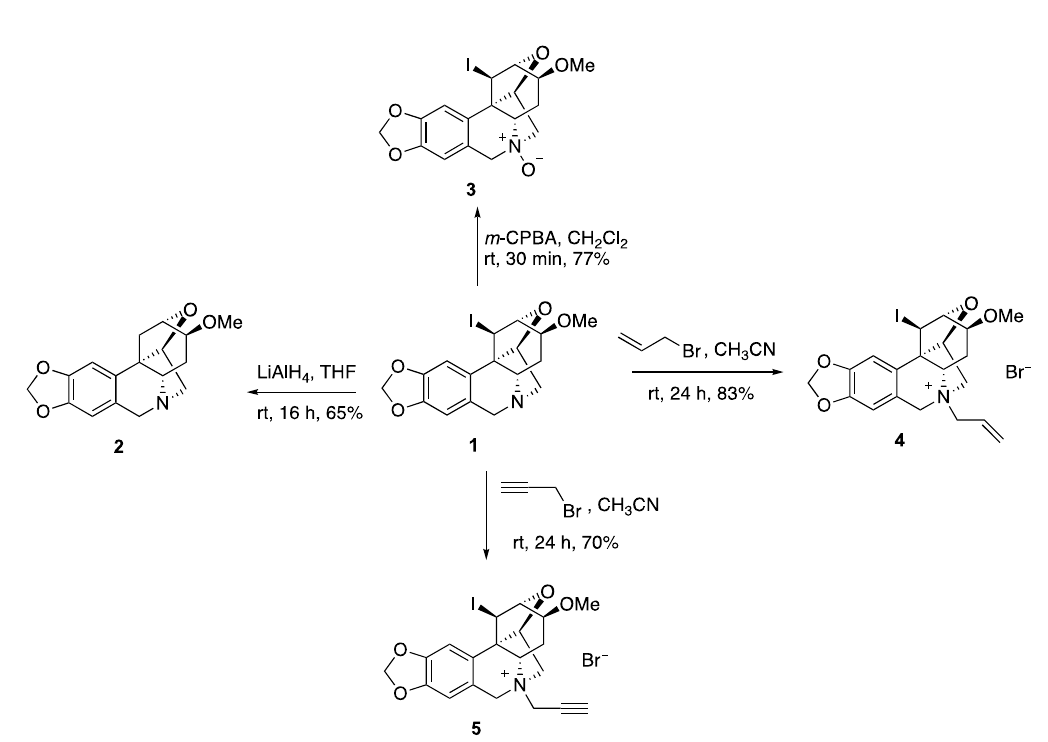
Figure 2. Derivatization of compound 1.